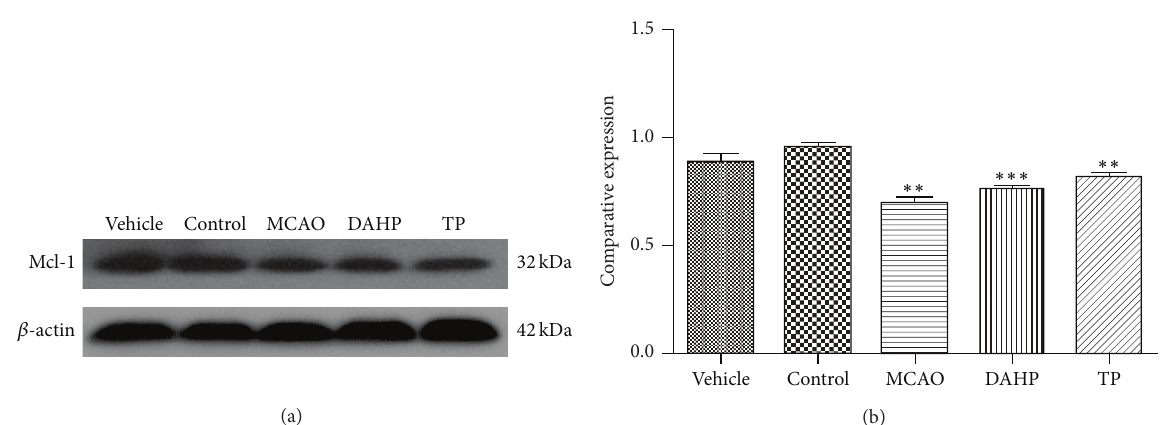
Figure 4: Western blot was conducted to detect the expression level of Mcl-1 among each group, which is consistent with Beclin-1 expression. Western blot staining presents an increasing tendency in Mcl-1 in DAHP and TP but a decrease in MCAO. (a) Compared with vehicle and control, the image shows a slight decreasing in MCAO, and the DAHP and TP were very likely to be the same level. (b) The mean change in Mcl-1 was significant. MCAO has a decrease, while DAHP and TP attenuated the tendency. DAHP and TP can be compared with normal control with a small fluctuation of 5%–10%. Values are the means ± SEMs. ∗ 𝑃 < 0.05 ; ∗∗ 𝑃 < 0.001 ; ∗∗∗ 𝑃 < 0.0001 ; n.s.: no